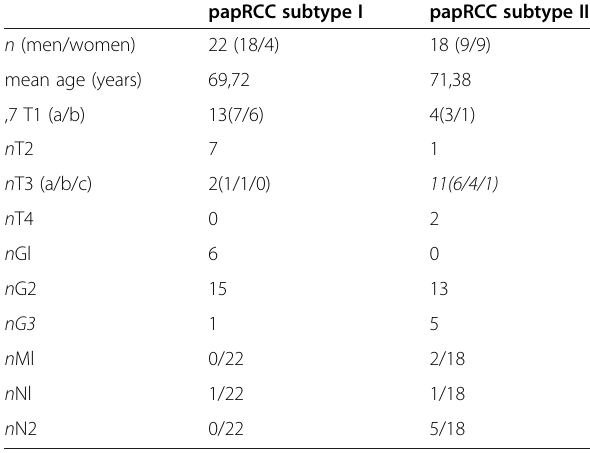
Table 1 Clinical and pathological data of analysed cases papRCC subtype